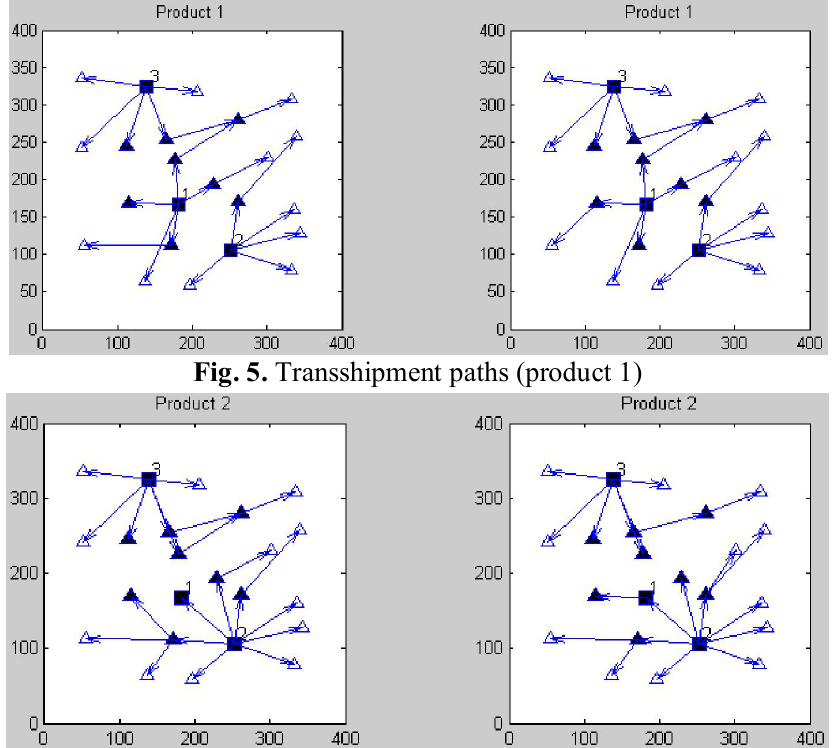
Fig. 6. Transshipment paths (product